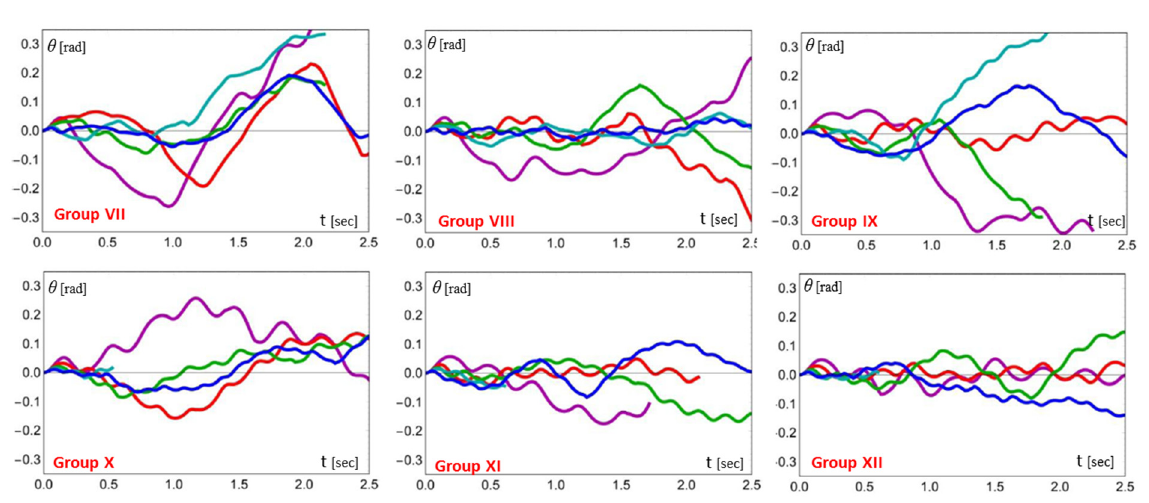
Figure 11. Rotation time histories ϑ (t) diagrams. Groups of conditions VII–XII (Table 3).